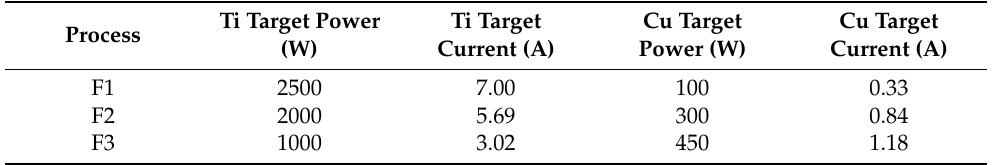
Table 2. The target powers for fabricating films with different Cu and Ti contents by magnetron sputtering.